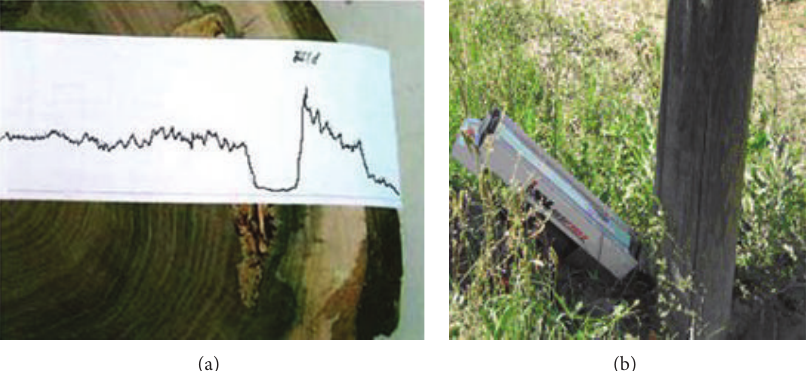
Figure 2: (a) The determination of interior defects and decay by IML-RESI F-300. (b) 45 ∘ -adaptor allows determining defects and decay below the ground